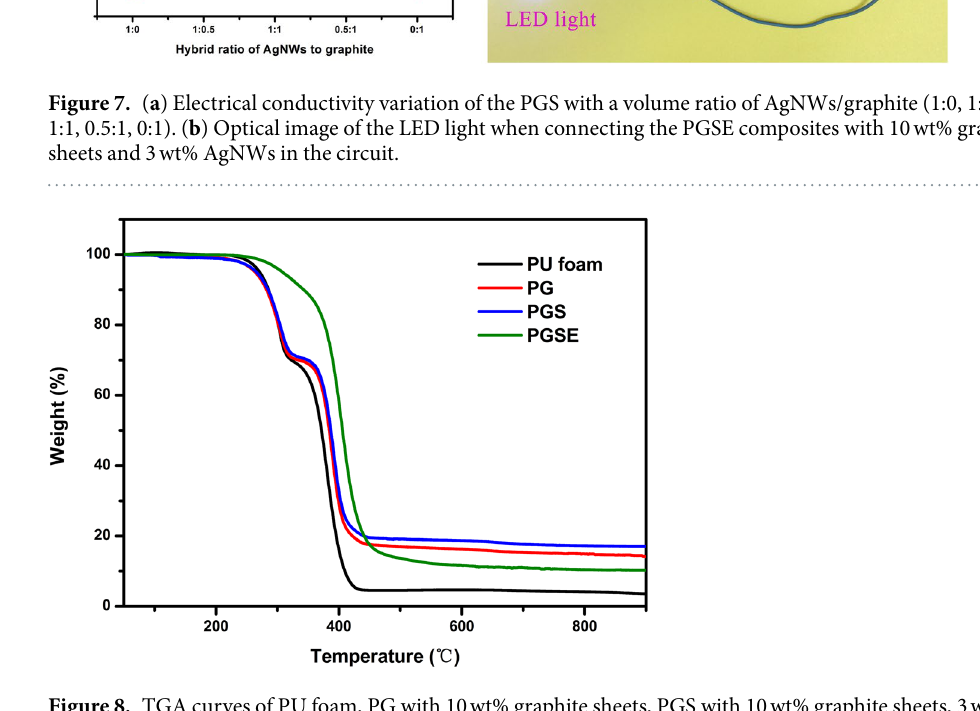
Figure 8. TGA curves of PU foam, PG with 10 wt% graphite sheets, PGS with 10 wt% graphite sheets, 3 wt% AgNWs, and PGSE composite with 10 wt% graphite sheets and 3 wt% AgNWs,